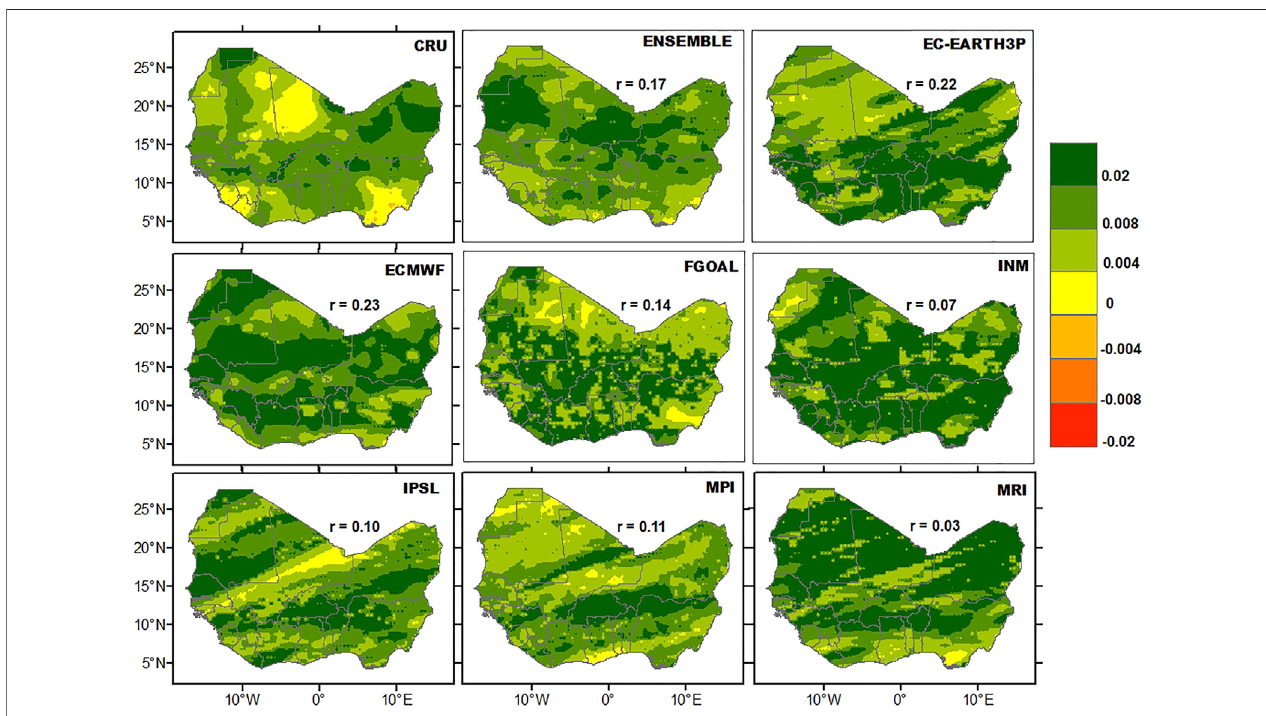
FIGURE 6 | Same as Figure 5 but for